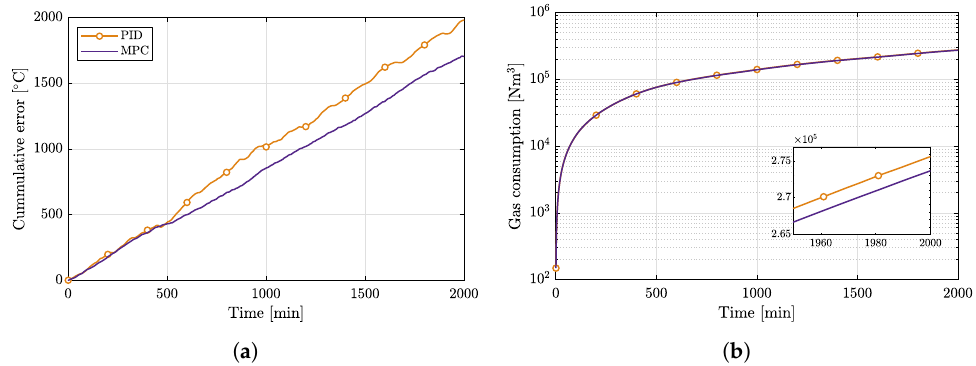
Figure 9. A comparison of gas consumption versus the cumulative control error for both MPC- and PID-based control loops. The gas consumption is reduced in case of the MPC controller; this becomes evident from the enlarged part of the right-hand plot. ( a ) Comparison of the cumulative control error (lower is better). ( b ) Comparison of gas consumption (lower is